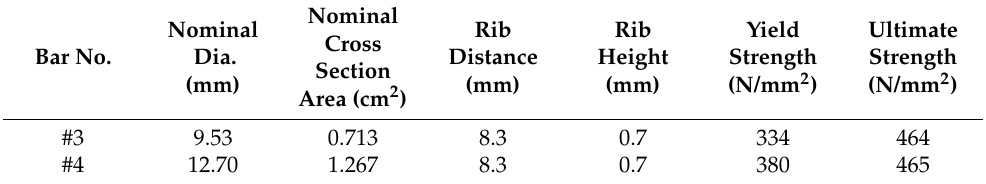
Table 4. The physical and mechanical properties of the steel rebars. Table 2. The physical and mechanical properties of the steel rebars.